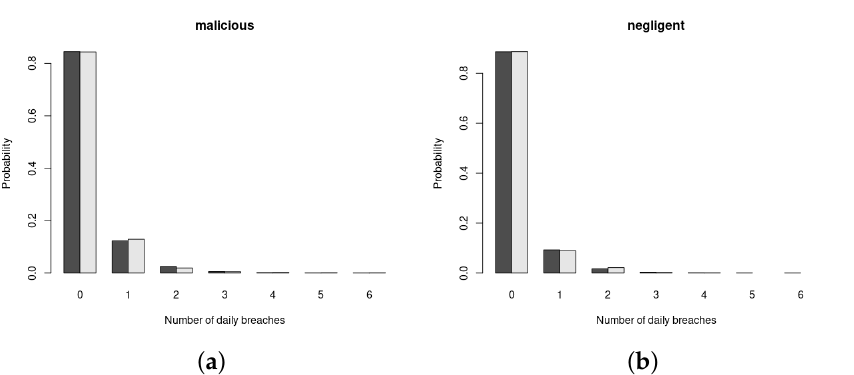
Figure 2. Empirical (light gray) vs. estimated (dark gray) distributions of the daily frequency of breaches for ( a ) malicious and ( b ) negligent breach types, respectively. Data for all but MED type companies as reported in the PRC dataset in the time period 2010–2019.